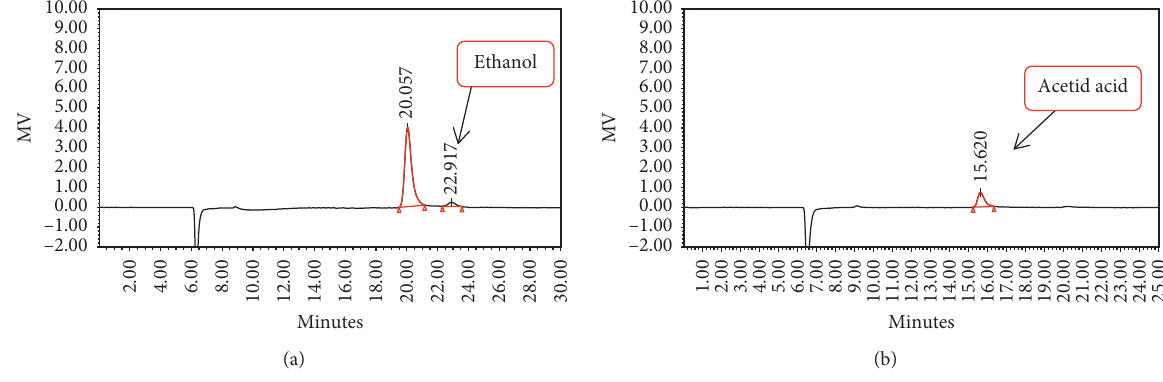
Figure 4: Chromatograms of ethanol and acetic acid standards.